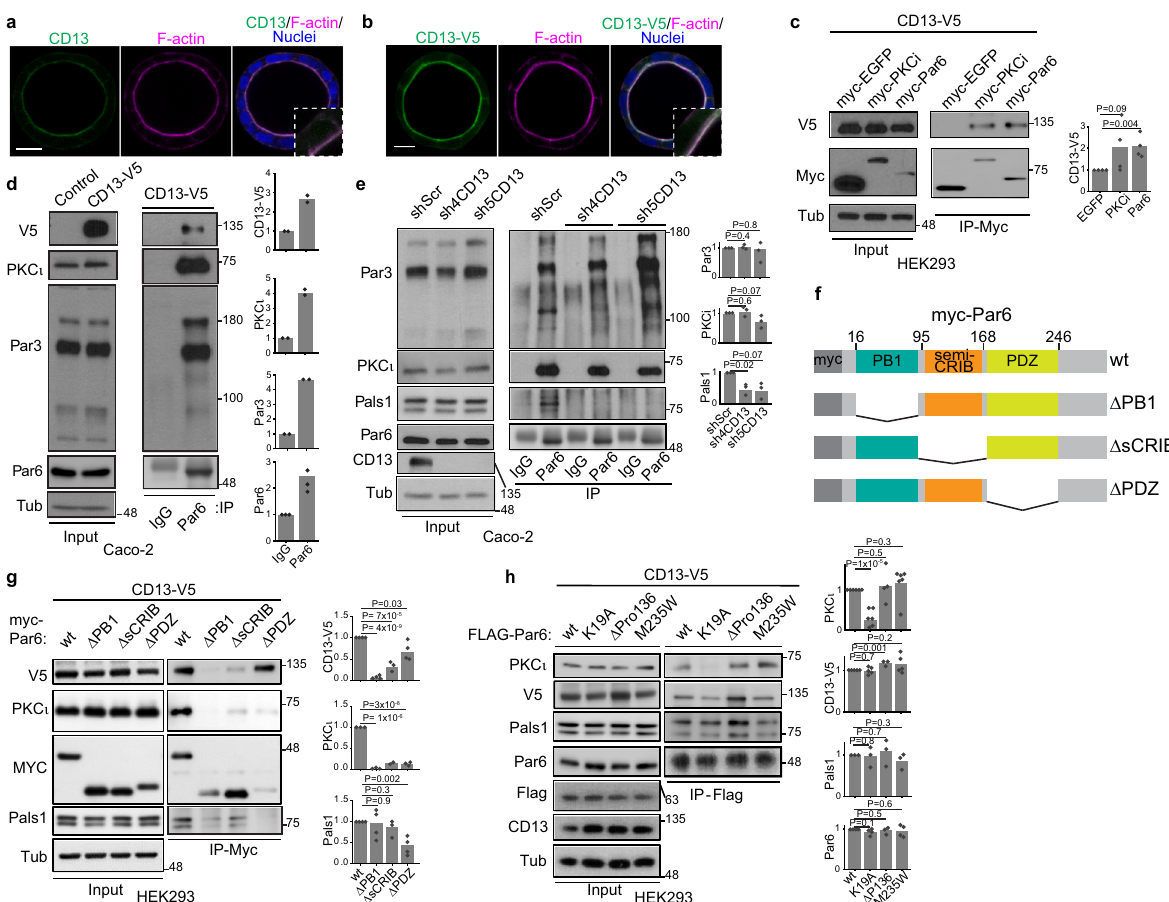
Fig. 1 CD13 localizes at the apical domain of 3D Caco-2 cysts and associates with PB1 domain of Par6. a , b Confocal images of polarized Caco2 cysts following 10 days in culture and immunostained for endogenous CD13 ( a , green) or V5-tagged CD13 ( b , green) and F-actin (phalloidin, magenta). Images are representative from three independent experiments. c Co-immunoprecipitation of CD13 and EGFP, PKC ι , or Par6 was performed with anti-myc in HEK293 cells. The presence of CD13 in immunoprecipitates was determined by western blot analysis using anti-V5. Graphs to the right show quanti fi cation of band intensities from n = 4 independent experiments. d Immunoprecipitation was performed with IgG or anti-Par6 in stably expressed CD13-V5 Caco-2 cells and blotted for V5, PKC ι , Par3, and Par6. Graphs to the right show quanti fi cation of band intensities from n = 2 independent experiments. e Immunoprecipitation was performed with anti-Par6 antibody or IgG control from shScr, sh4-CD13 and sh5-CD13 knock-down Caco-2 cell lysates and blotted for Par3, PKC ι , Pals1, Par6, and CD13. Graphs to the right show quanti fi cation of band intensities from n = 3 independent experiments. f Schematic diagram showing Par6 domains and deletion mutants. g Co-immunoprecipitation of CD13 and wild-type (wt) or Par6 deletion mutants was performed with anti-myc in HEK293 cells. Graphs to the right show quanti fi cation of band intensities from n = 4 independent experiments. h Co-immunoprecipitation of CD13 and wild-type (wt), or Flag-tagged Par6 containing point mutations (K19A, Δ P136, M235W) performed with anti-Flag antibodies in HEK293 cells. Graphs to the right show quanti fi cation of band intensities from independent experiments (PKC ι , n = 6; CD13-V5, n = 5; Pals1, n = 3; Par6, n = 4). p -values were calculated by ANOVA with Tukey ’ s posthoc test for multiple comparisons ( c , e , g , h ). Bars: a and b , 10 μ